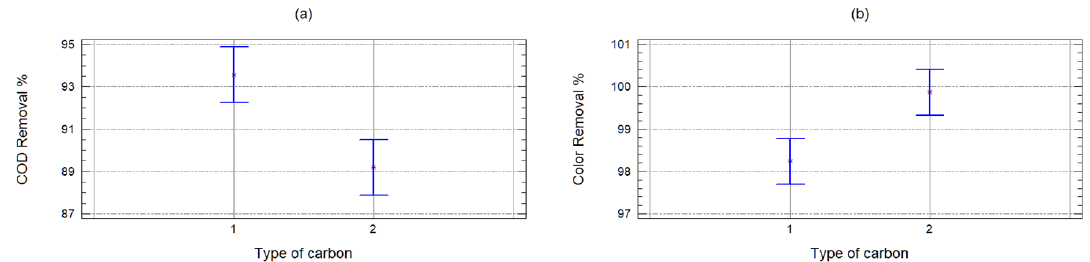
Figure 4. Mean charts of the COD (a) and color (b) removal efficiency in the FE, according to the type of carbon (1 = GAC and 2 = PAC).